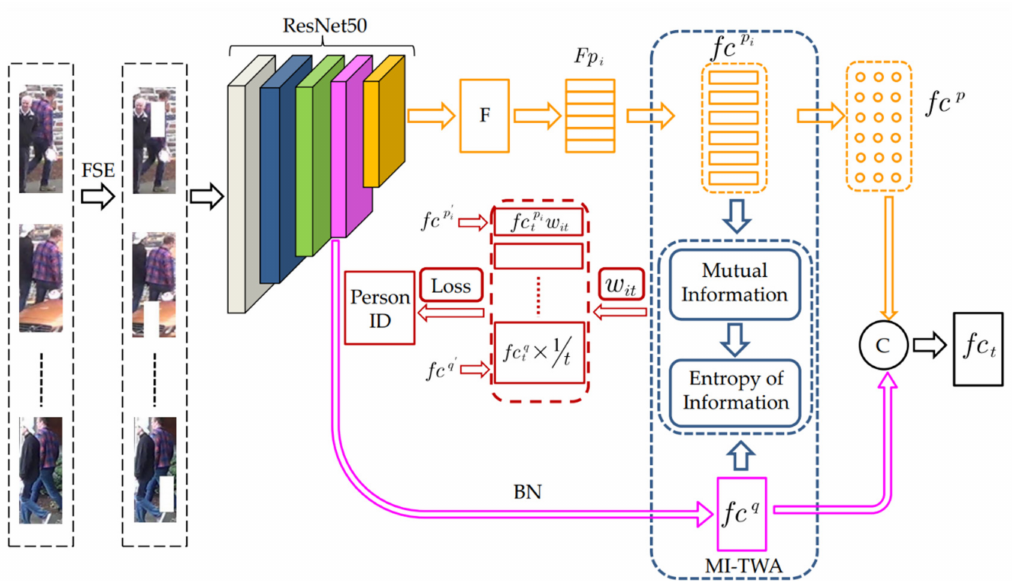
Figure 1. Architecture of our method. The FSE-processed video sequence is used as the input of the network. The ResNet-50 is used to extract the global feature fc q and the partial feature fc p . fc q and fc p are fused to obtain the frame-level image feature fc t . fc p i and fc q are aggregated by the temporal weights. The temporal weight W it of fc p i is calculated by mutual information entropy value. The temporal weight of fc q is calculated by equal weighting. fc p (cid:48) i and fc q (cid:48) are concatenated as the final feature representation of this sequence. By combining L triplet and L soft max , the network model is trained.